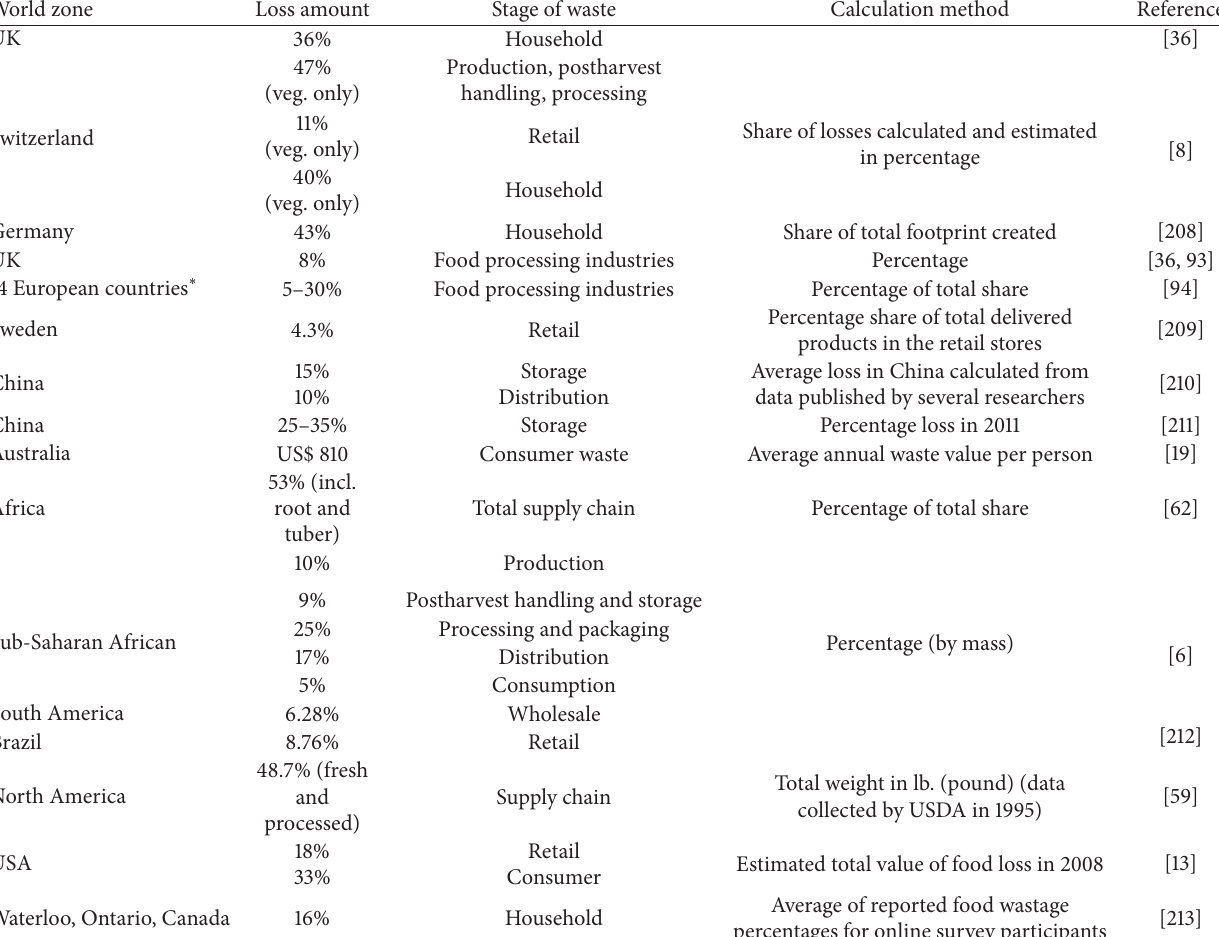
Table 3: Amount/percent/value of fruit and vegetable waste in the world food supply